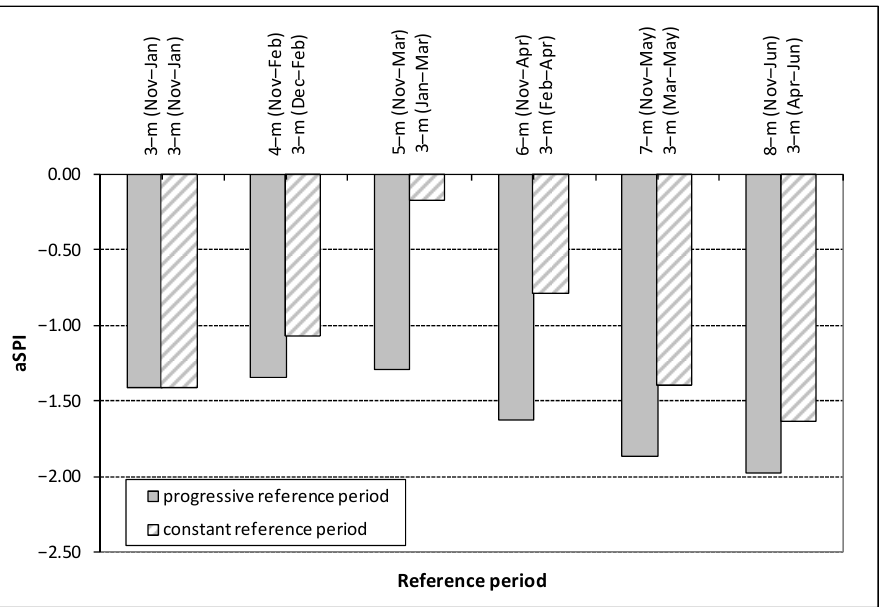
Figure 4. Drought monitoring with aSPI during cropping season (winter wheat crop), using constant and progressive reference periods for an indicative drought year (location: Alexandroupolis–Greece; hydrological year: 1984–1985).